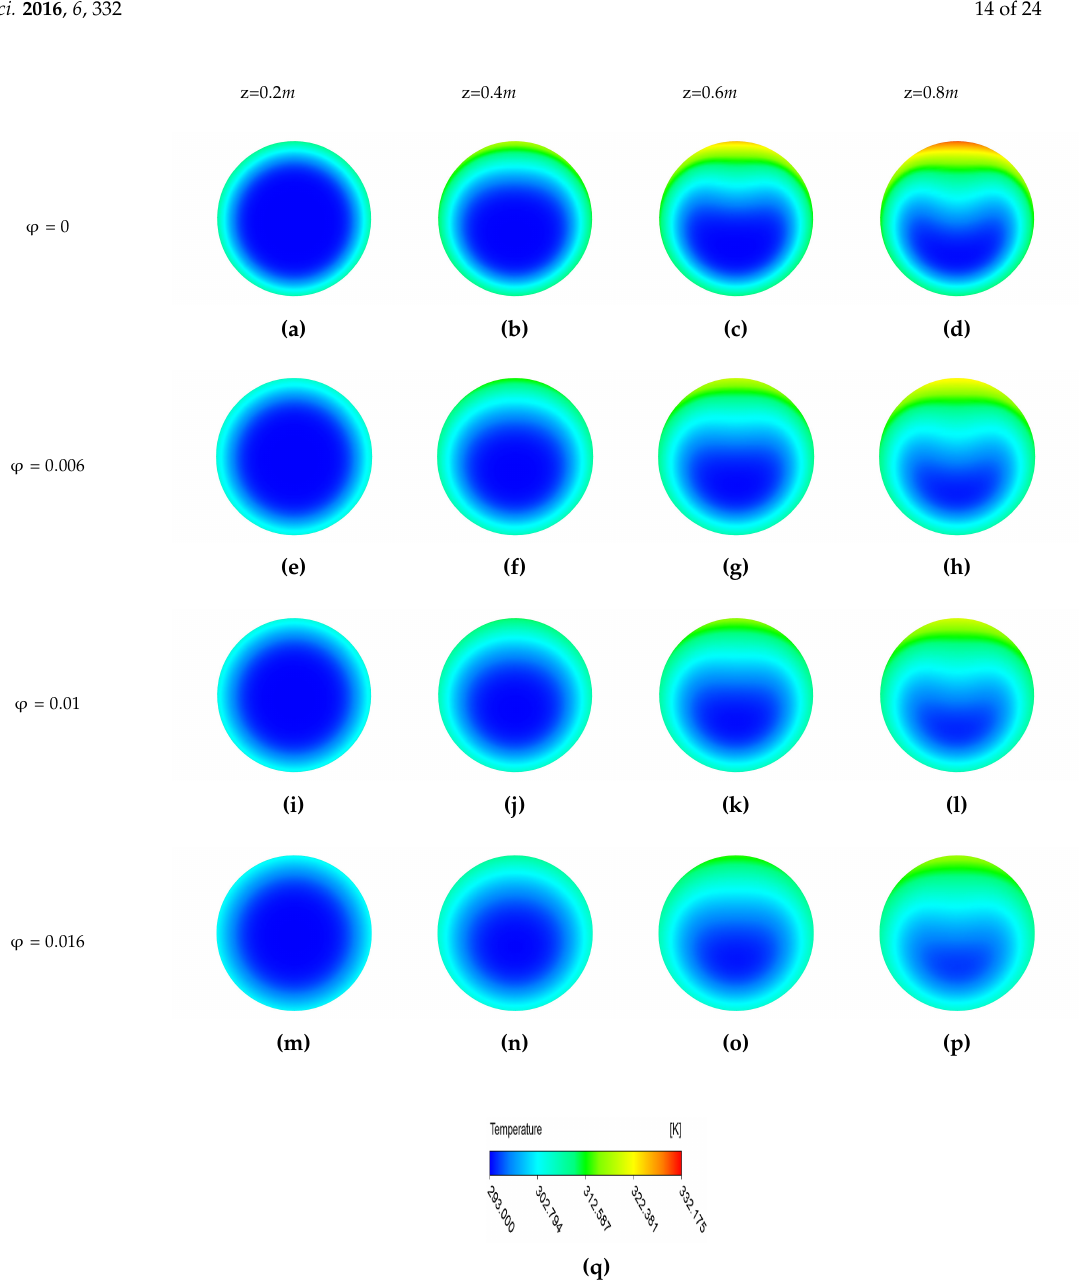
Figure 9. Maps of temperature T at four axial positions: z = 0.2 m ( a , e , i , m ); z = 0.4 m ( b , f , j , n ); z = 0.6 m ( c , g , k , o ); and z = 0.8 m ( d , h , l , p ). Results obtained for d np = 42 nm, Re = 1600 and four volume fractions of Al 2 O 3 nanoparticles: ϕ = 0 ( a – d ); 0.006 ( e – h ); 0.01 ( i – l ); and 0.016 ( m – p